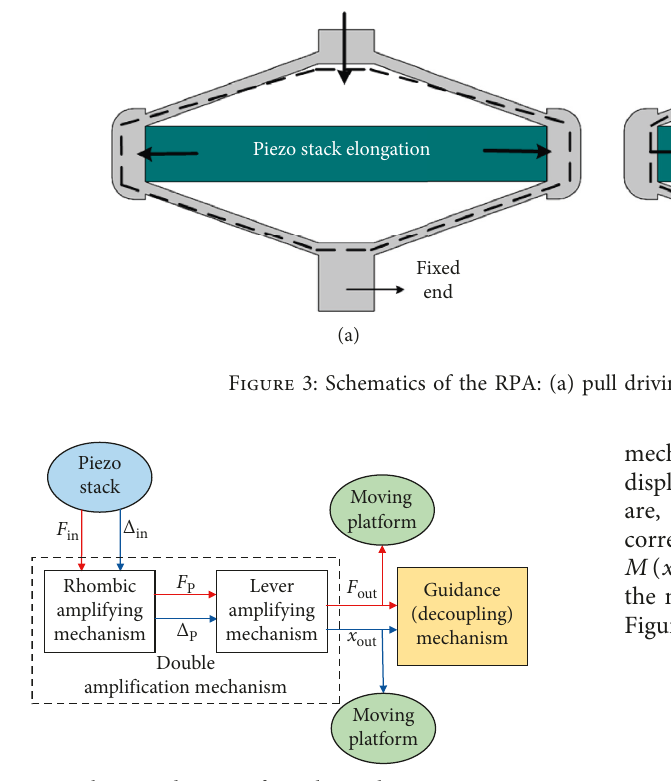
Figure 4: Schematic diagram of translational motion transmission.